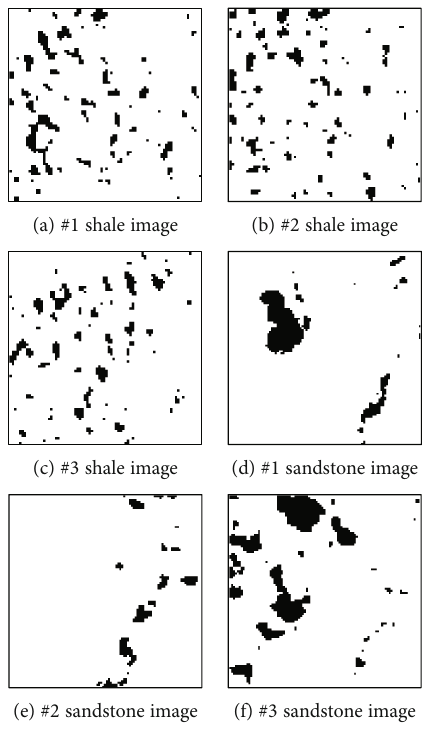
Figure 7: Some shale and sandstone cross-section images from real volume data.